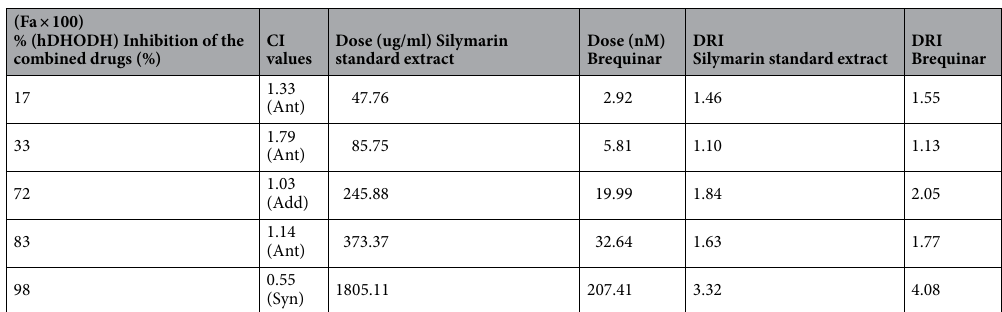
Table 7. Fractional inhibition of hDHODH, combination index values (CI) and DRI values of silymarin standard extract and brequinar in combination at several effect levels. Fa signifies fraction affected. CI < 1, = 1, and > 1 indicate synergism (Syn), additive effect (Add), and antagonism (Ant), respectively. DRI > 1 indicates favourable dose reduction (in fold) for the drug in combination.